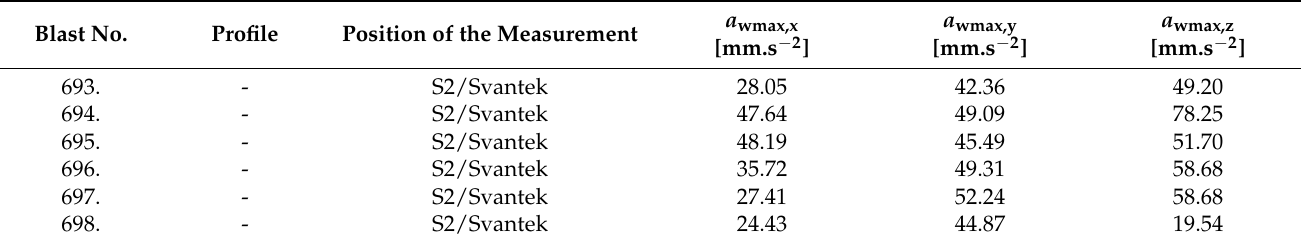
Table 6. Measured values of peak acceleration in blasts (source: